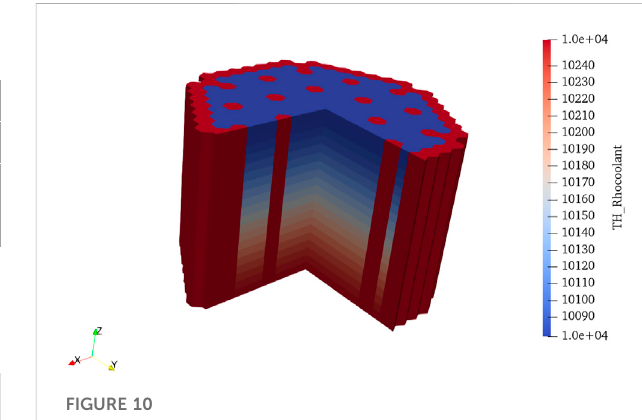
FIGURE 10 Density distribution of the coolant.